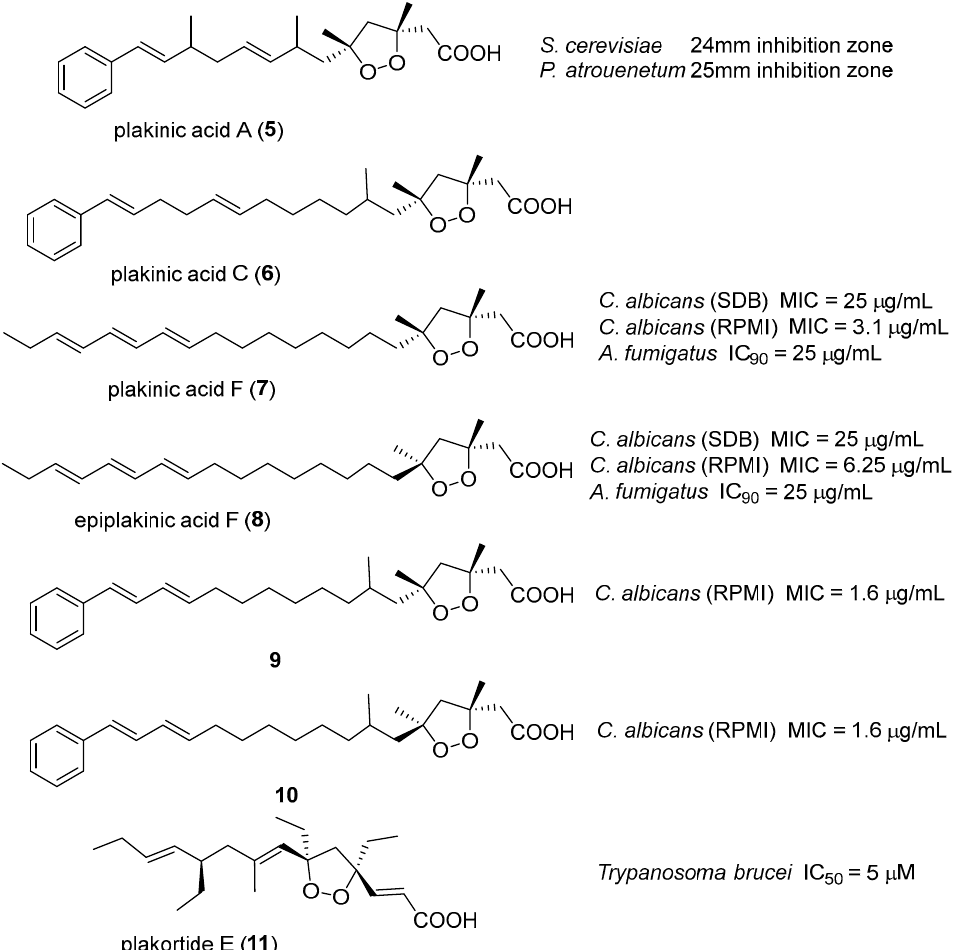
Scheme 1. Antifungal and anti-parasitic activity of 1,2-dioxolanes, isolated from the sponges Plakinidae